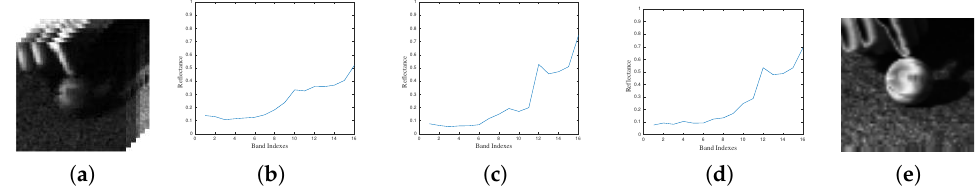
Figure 2. The result of proposed dimensionality reduction method: ( a ) original HSI; ( b ) global spectral curve; ( c ) local spectral curve; ( d ) final spectral curve; ( e ) result